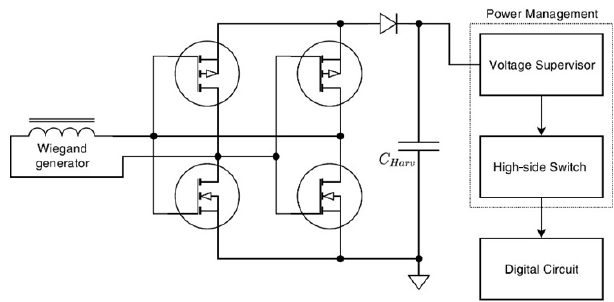
Figure 2. Harvesting circuit supplying the digital circuit with en- ergy from the Wiegand generator.